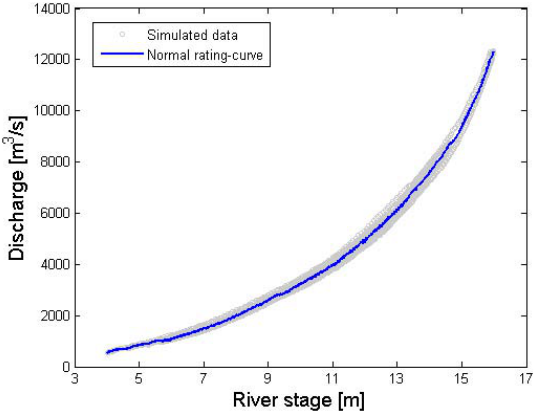
Fig. 5. Cremona cross-section: simulated h(t) − Q(t) pairs for 10 historical flood events (grey dots) adopting the calibrated Piacenza-Pontelagoscuro quasi-2-D model; normal rating-curve (blue